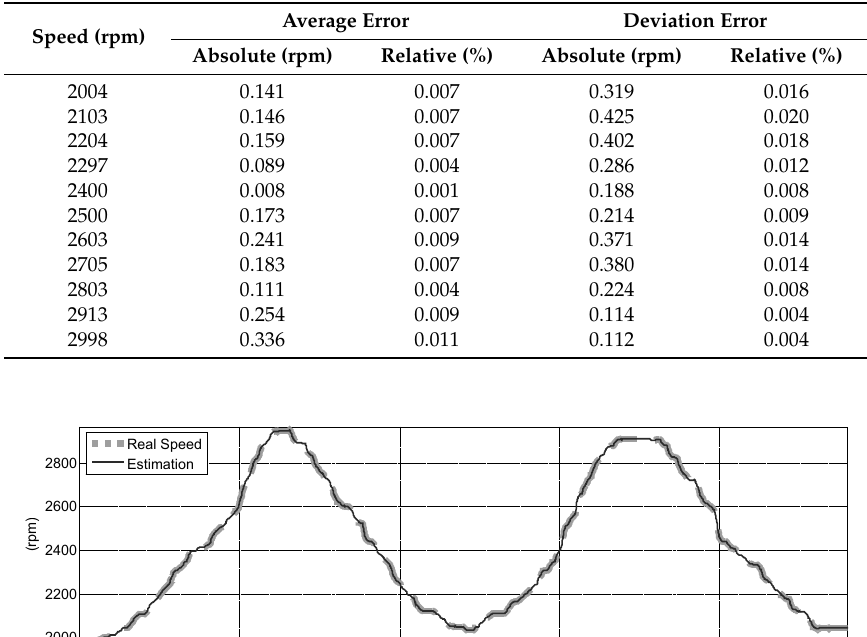
Table 1. Speed measurement errors.